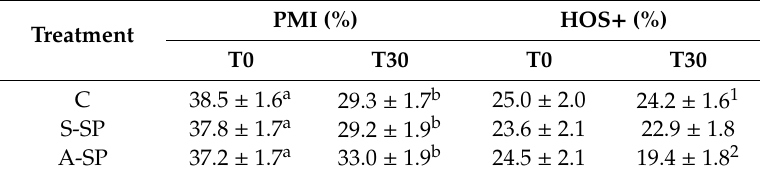
Table 2. Viability and plasma membrane integrity (HOS+) after thawing (T0) and after an incubation time of 30 min (T30): C (control group), S-SP (standard Sp), A-SP (above-standard SP).